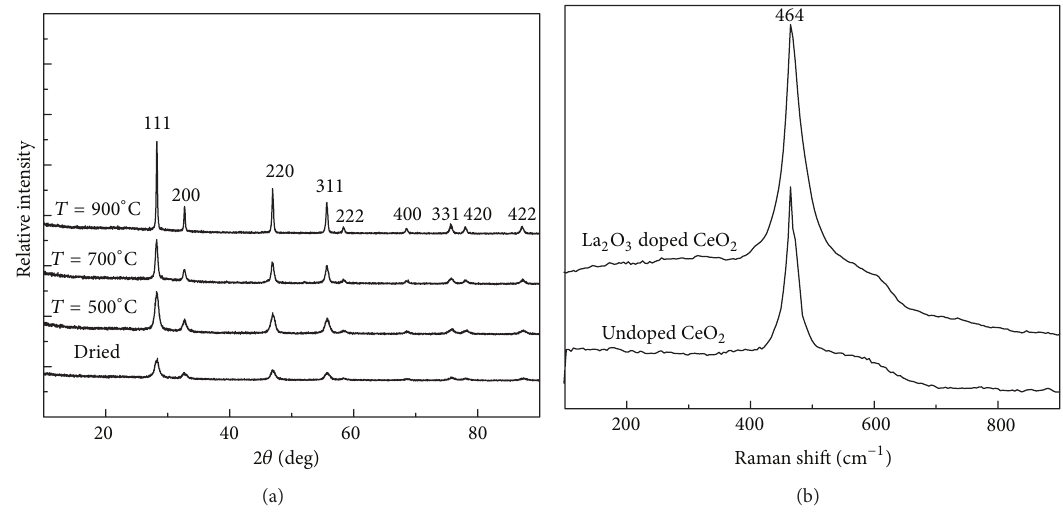
Figure 2: XRD patterns of 10mol% La 2 O 3 doped CeO 2 calcined at different temperatures (a); Raman spectra of 10mol% La 2 O 3 doped CeO 2 and undoped CeO 2 (b).